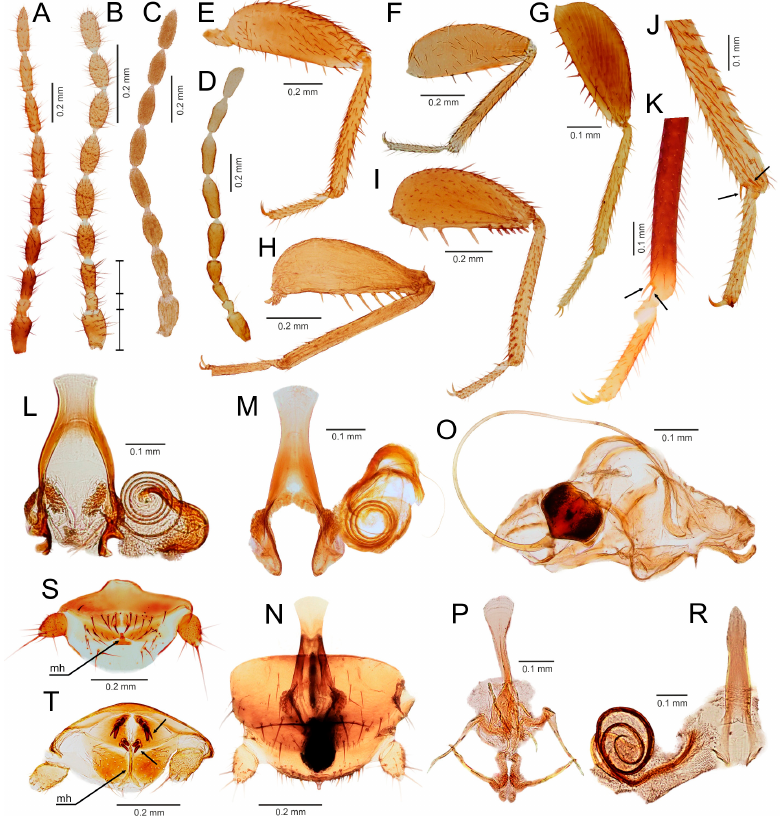
Figure 5. Morphological characters of Spiralizoridae: Spiralizorinae. ( A ) right antenna of Spiralizoros cervicornis , male, Brunei; ( B ) left antenna of Spiralizoros magnicaudelli with lengths of the three basal antennomeres indicated, male, Malaysia; ( C ) right antenna of Scapulizoros novobritannicus , female, Papua New Guinea (New Britain); ( D ) right antenna of Brazilozoros weidneri , male, Brazil; ( E ) right hind leg of Spiralizoros cervicornis , male, Brunei; ( F ) right hind leg of Brazilozoros weidneri , male, Brazil; ( G ) right hind leg of Centrozoros sp. 1, female, Ecuador; ( H ) right hind leg of Scapulizoros novobritannicus , female, Papua New Guinea (New Britain); ( I ) right hind leg of Cordezoros zimmermani , female, Fiji; ( J ) detail of right metatibia of Centrozoros neotropicus , female, Costa Rica; arrows indicate apical spurs ( K ) detail of right metatibia of Spiralizoros magnicaudelli , male, Malaysia; arrows indicate apical spurs ( L ) male genitalia of Spiralizoros cervicornis , Brunei; ( M ) male genitalia of Spiralizoros magnicaudelli , ventral view, Malaysia; ( N ) ventral view of the apex of abdomen of Spiralizoros magnicaudelli , male, Malaysia; ( O ) male genitalia of Cordezoros zimmermani , lateral view, Fiji; note: symmetry of genitalia and position of a heart-like sclerite are shifted due to slide mounting; ( P ) male genitalia of Brazilozoros weidneri , ventral view, Brazil; ( R ) male genitalia of Centrozoros hamiltoni , ventral view, Colombia; ( S ) abdomen end of Spiralizoros magnicaudelli in caudal view, male, Malaysia; mh—mating hook on tergite XI; ( T ) abdominal apex of Brazilozoros weidneri , male, Brazil; arrows indicate sensilla, mh - mating hook on tergite XI. Species included. Centrozoros snyderi (Caudell, 1920), stat. restit.; C. cramptoni (Gurney, 1938); C. gurneyi (Choe, 1989); C. hamiltoni (New, 1978); C. mexicanus (Bolívar y Pieltain, 1940); C. neotropicus (Silvestri, 1916); C. manni (Caudell, 1923), and Centrozoros sp. 1 (unpublished).